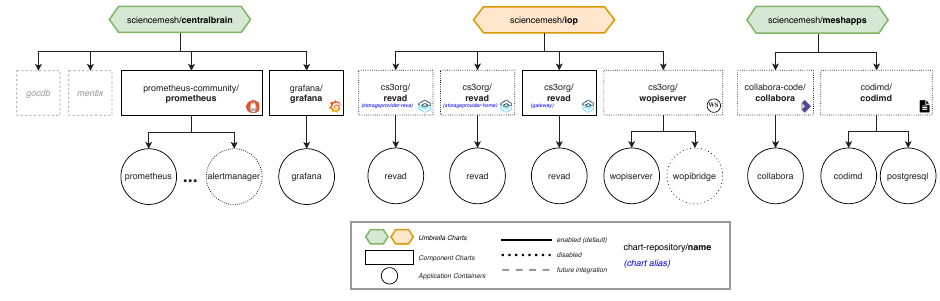
Figure 4. ScienceMesh project chart